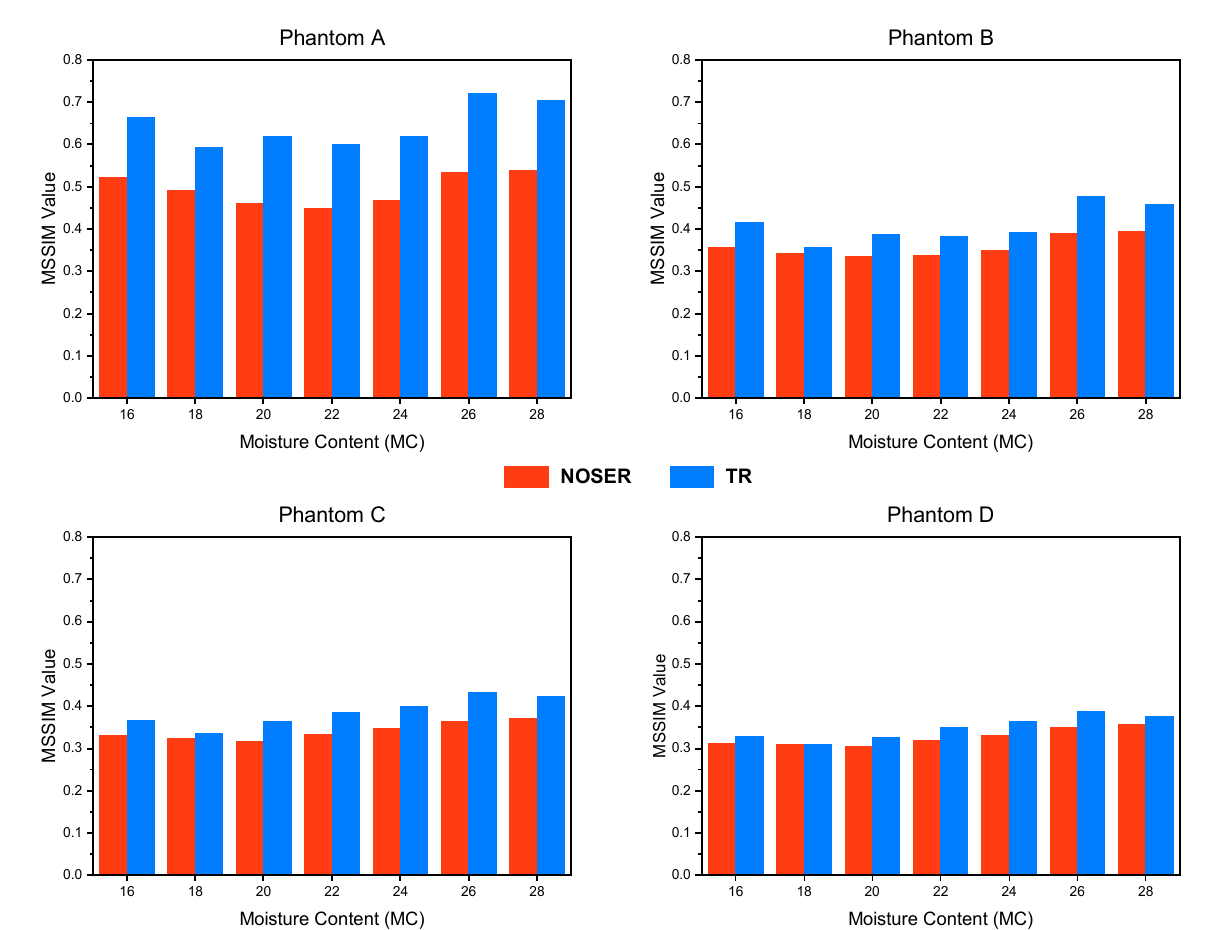
Figure 7. MSSIM Index graphs computed on the reconstructed images of Phantom A, B, C, and D.